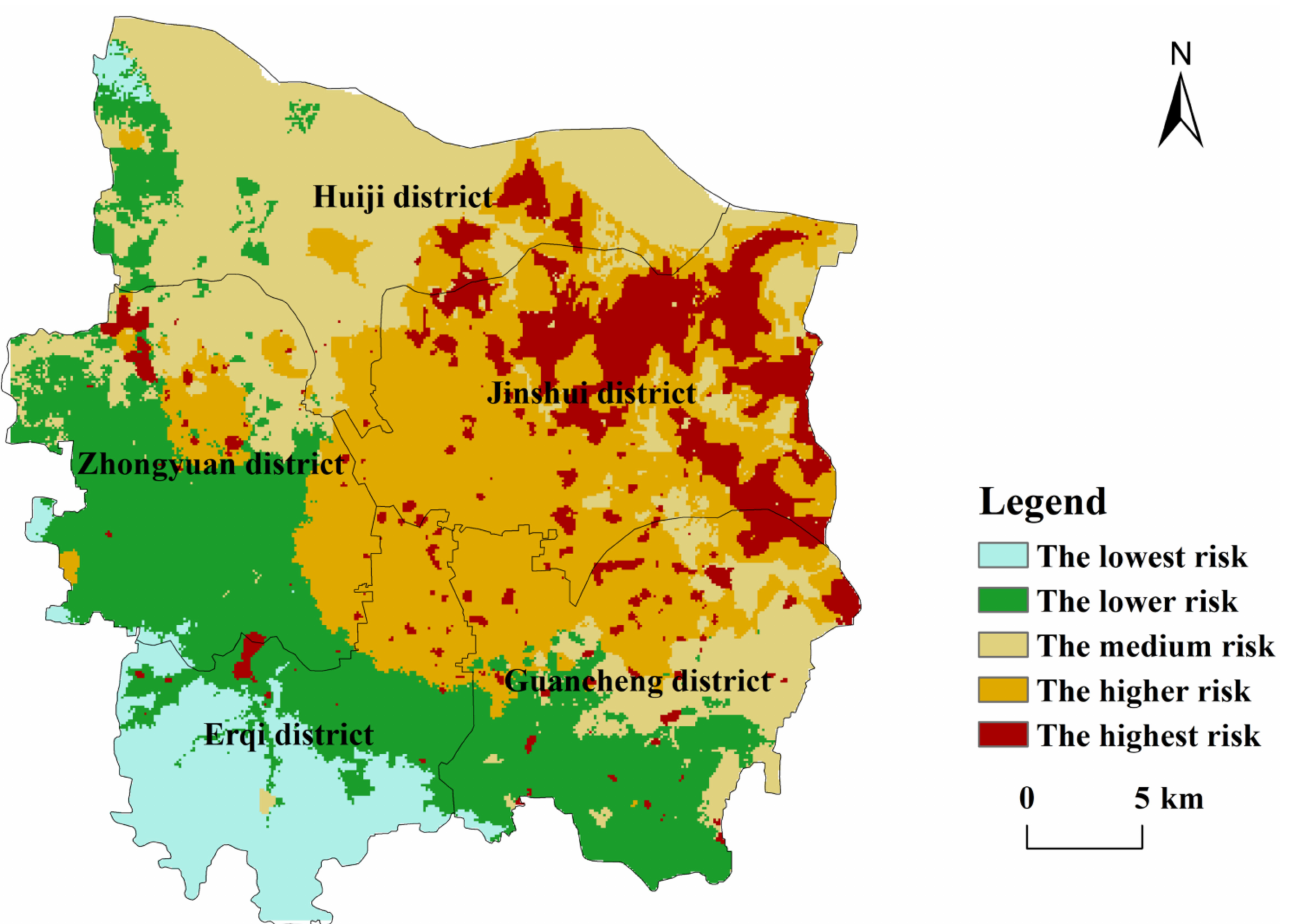
Figure 10. Spatial distribution map of flood risk in Zhengzhou based on the D-AHP and the SOM clustering